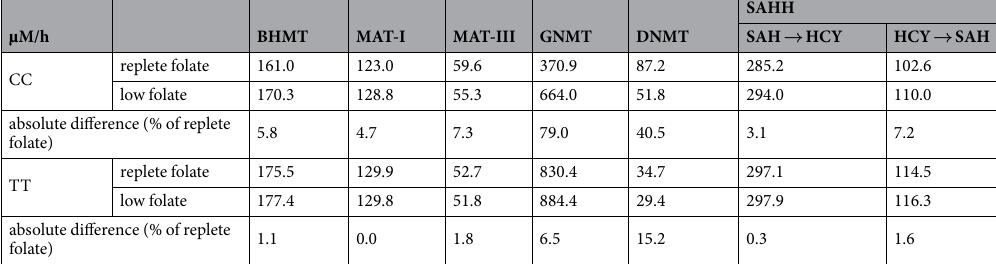
Table 10. Fluxes of the reactions catalyzed by the enzymes BHMT, MAT-I, MAT-III, GNMT, DNMT and SAHH for replete (18 µ M) and low (9 µ M) levels of total folate and for the CC and TT case of the C677T MTHFR polymorphism.